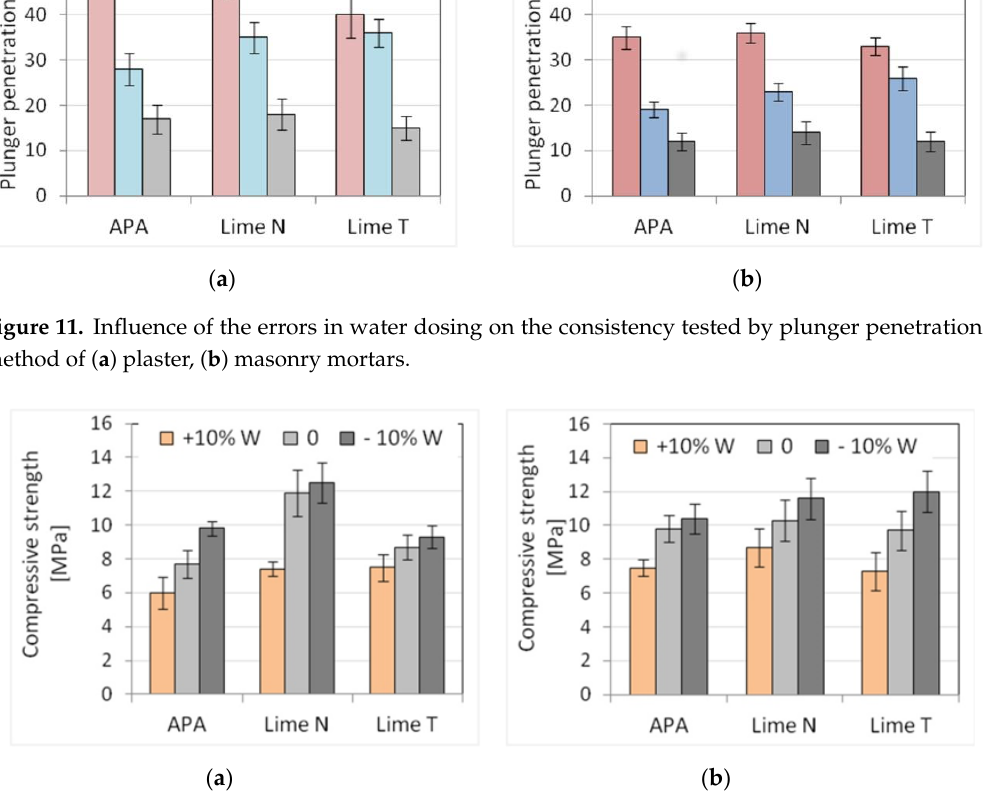
Figure 12. Influence of the errors in water dosing on the compressive strength: ( a ) plaster, ( b ) masonry mortars.